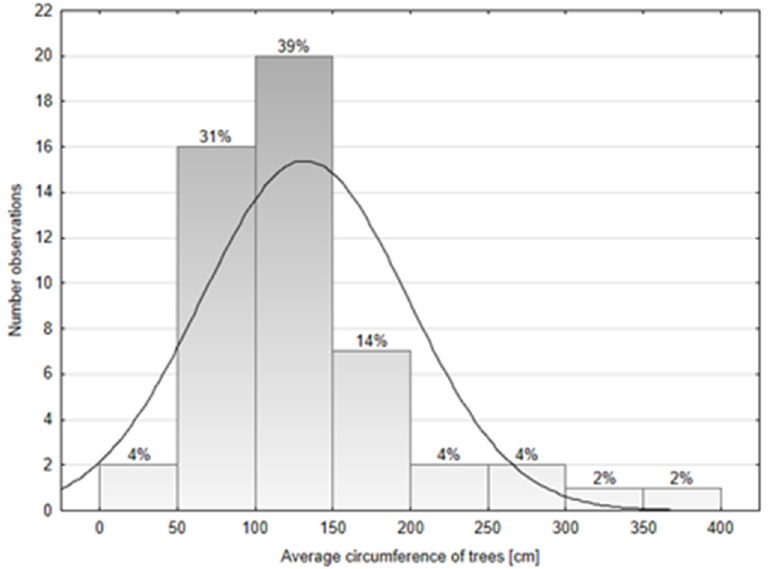
Figure 4. The distribution of Morus alba circumference. Percentage values represented the propor- tion of individuals trees of Morus alba in given circumference ranges (W Shapiro-Wilk test = 0.845; p ≤ 0.0001). The number of observations were calculated as mean for each square.